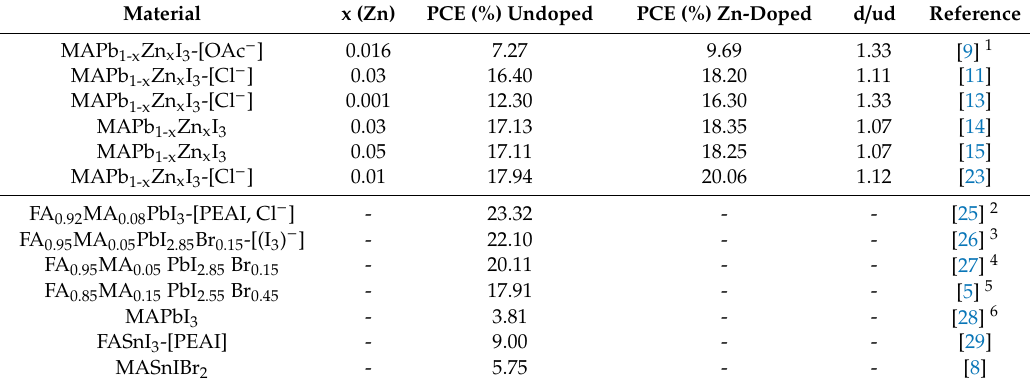
Table 2. Reported power conversion e ffi ciencies (PCE) for materials without zinc (undoped, ud) and Zn-doped (d) materials, together with their enhancement factors (d / ud). Compositions are estimated from their References. Additives are indicated in square brackets. A selection of certified world record e ffi ciencies is given in the last seven